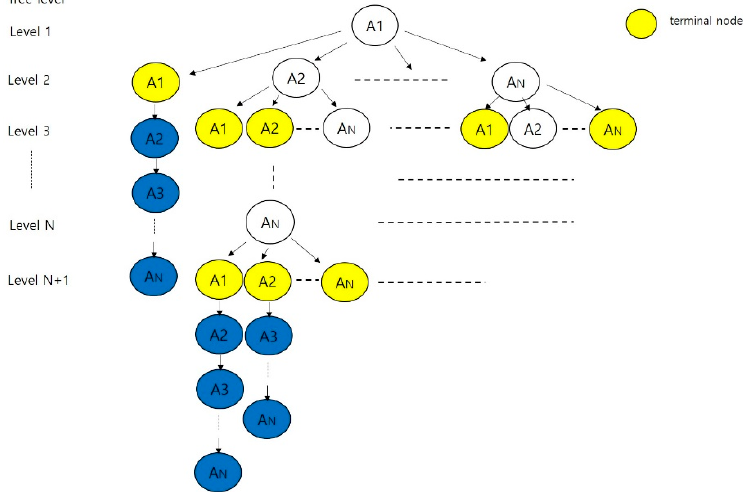
Figure 7. Tree using the proposed method.